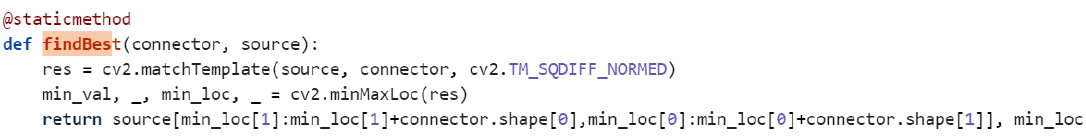
Figure 17. Best match connector search function using the matchTemplate primitive.